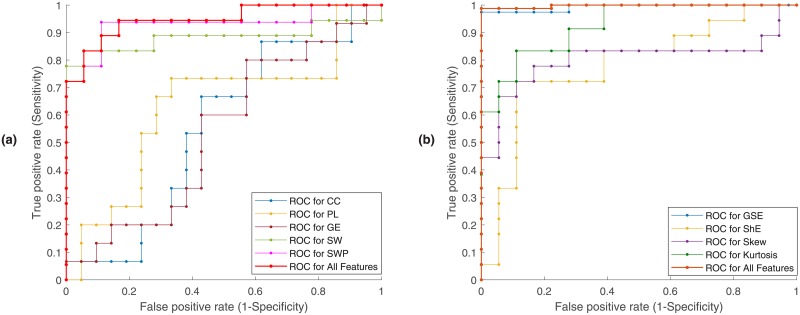
ROC curves for all features.a. Graph Theoretic Features; b. Graph Signal Features.